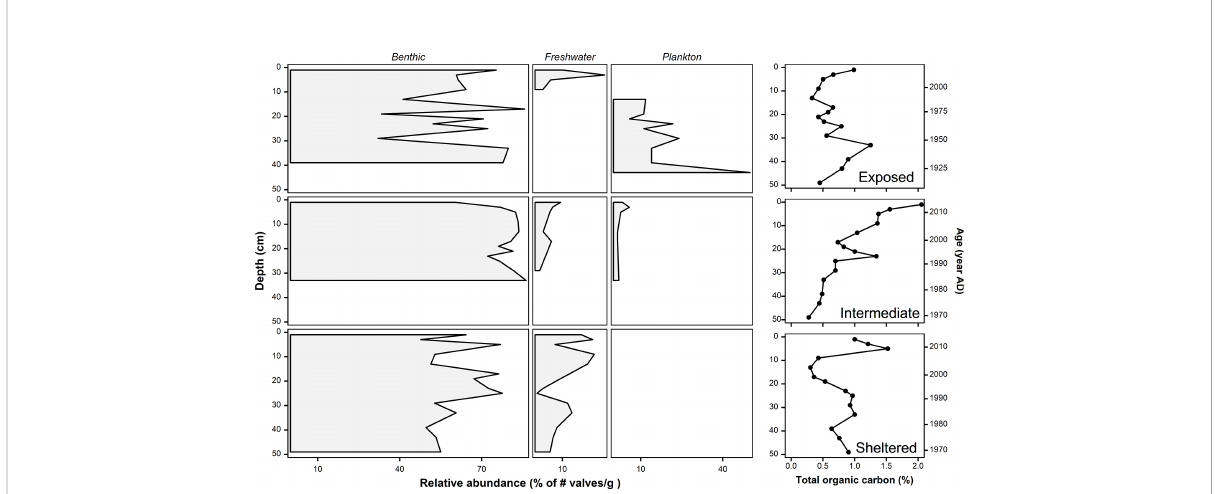
FIGURE 2 A stratigraphic diagram showing the relative abundance (%) of diatom guilds (benthic, freshwater and plankton) as well total organic carbon (%). Samples were analyzed in three cores, 50 cm-long each, at three sites representing different hydrodynamic regime sites: Exposed (top panel), Intermediate (middle panel) and Sheltered (bottom panel). Age estimates (right y-axis) are based on sediment accumulation rates obtained from 14C ages of shells retrieved from nearby cores (Proske et al.,